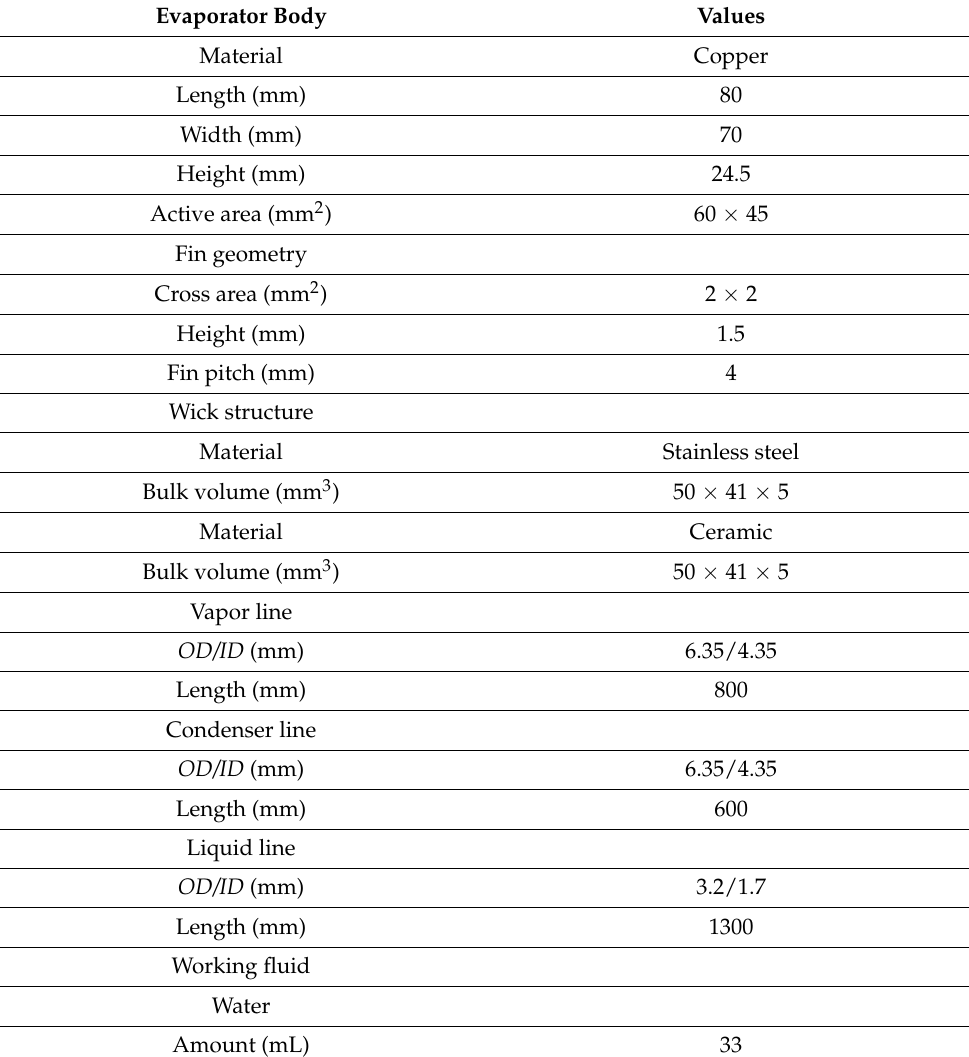
Table 3. Main parameters of the